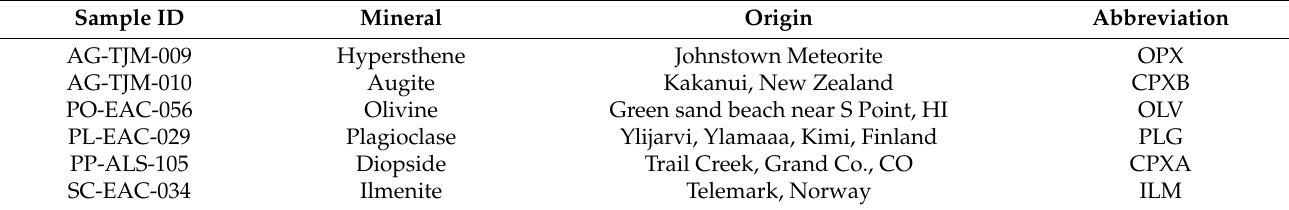
Table A2. Origin of endmember samples in Sections 3.1 and 3.3. All samples except for the AG-TJM-009 Hypersthene endmember, which is of meteoritic origin, originate from